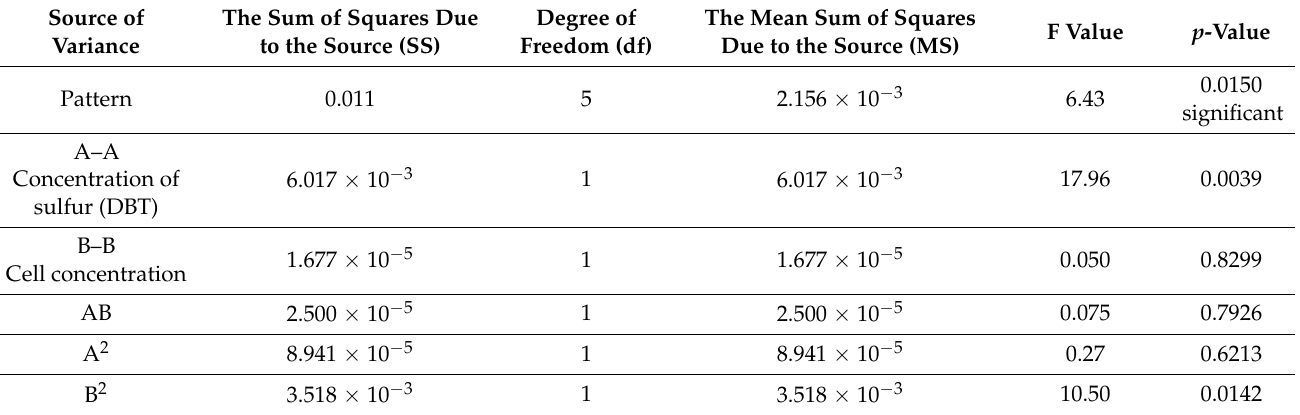
Table 3. ANOVA for evaluation of R 1 for Rhodococcus erythropolis IGTS8 in the absence of the nanostructure.